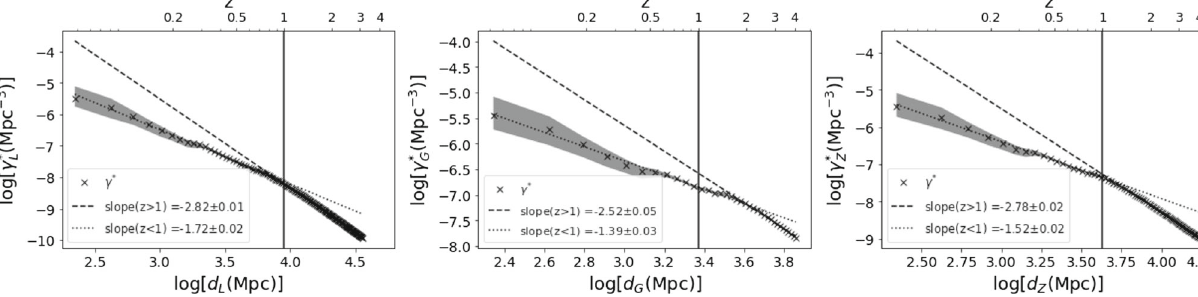
Fig. 14 Log–log graph of γ ∗ , γ ∗ and γ ∗ respectively vs. d L , d G and d z obtained with the red COSMOS2015 quiescent galaxy subsample in the L G z ranges z < 1 and 1 ≤ z ≤ 4 and respective distance measures. All results were obtained considering H 0 = 70 km/s/Mpc